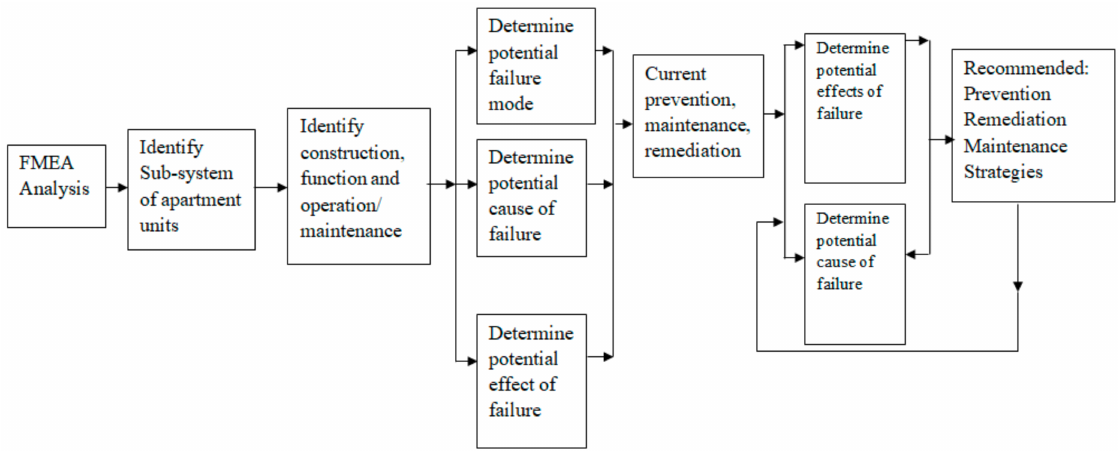
Figure 2. The Q-map of system Failure Modes and Effects Analysis (FMEA) analysis